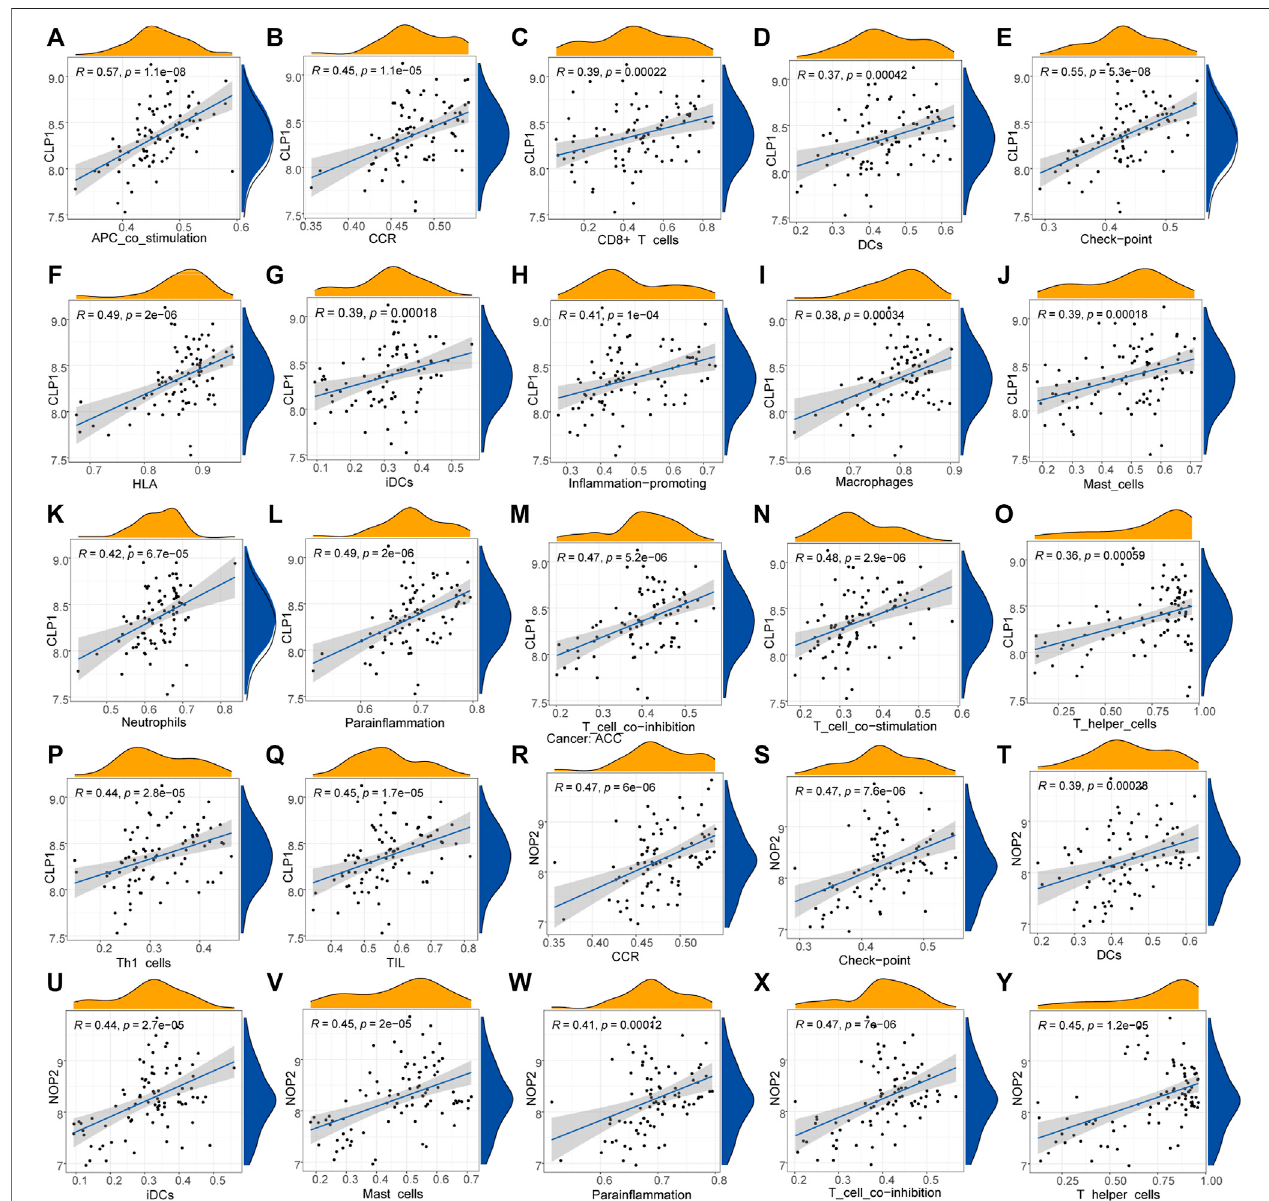
FIGURE 11 | Correlation between key genes and